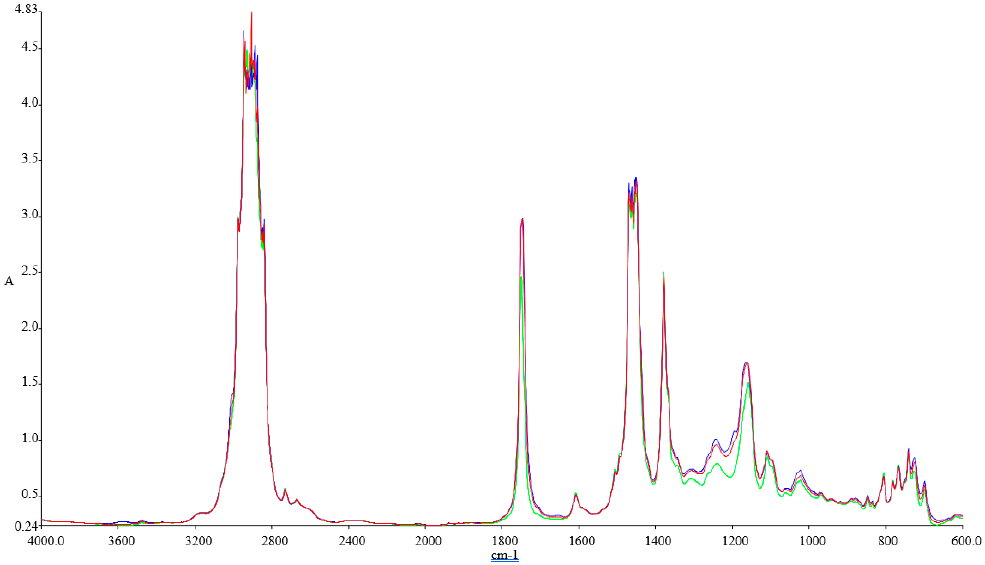
Figure 2. FTIR spectra of the tested fuel blends: Green-Ke, Blue-Ke+10%SF, and Red–Ke+10%SFP.